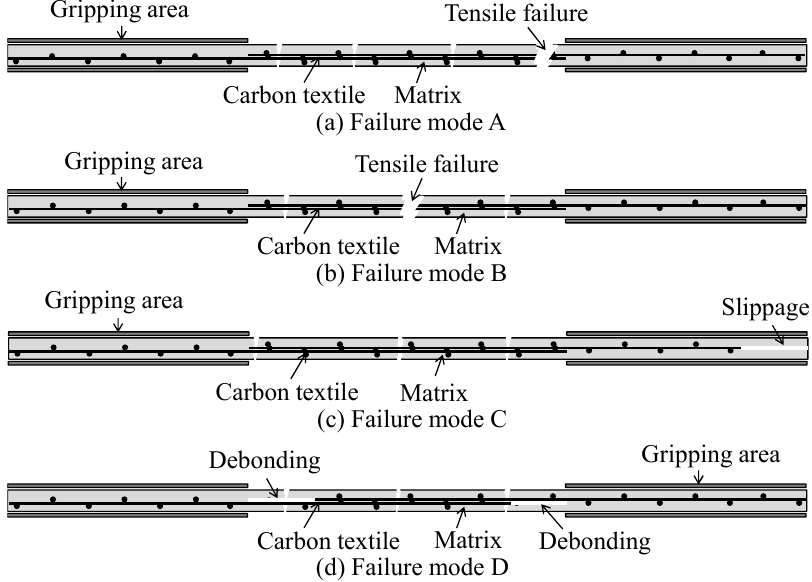
Figure 8. Failure modes of direct tensile tests of TRM test specimens.